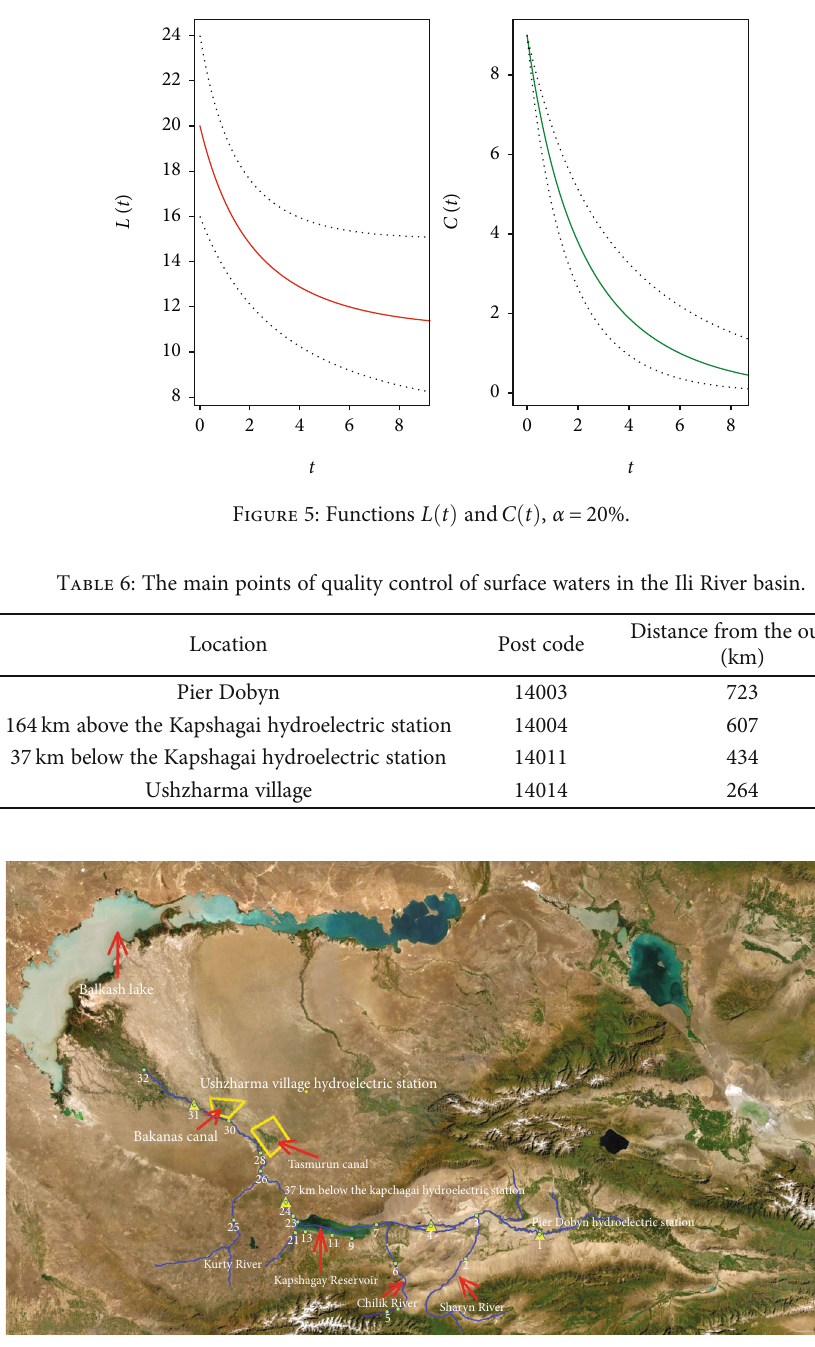
Figure 6: Location of hydrological posts on the map (yellow triangles denote hydrological